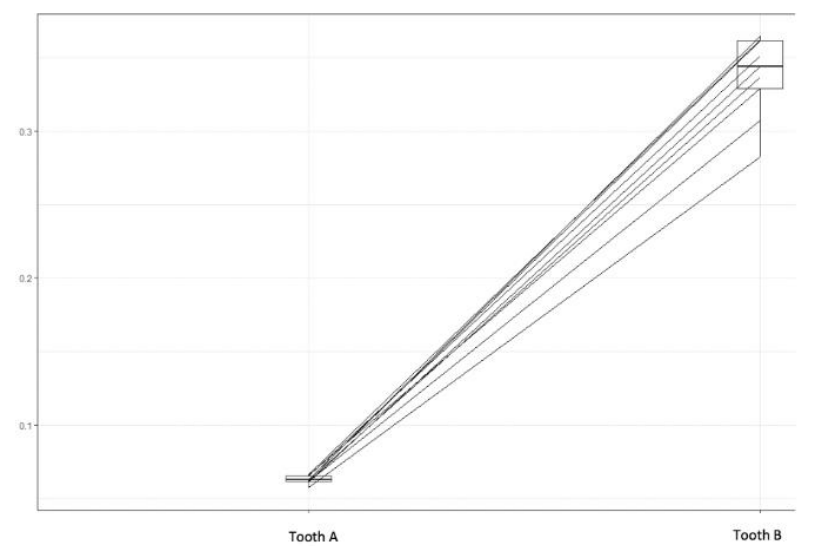
Figure 1. Comparative graph of initial values (Tooth A) and after application of acid attack